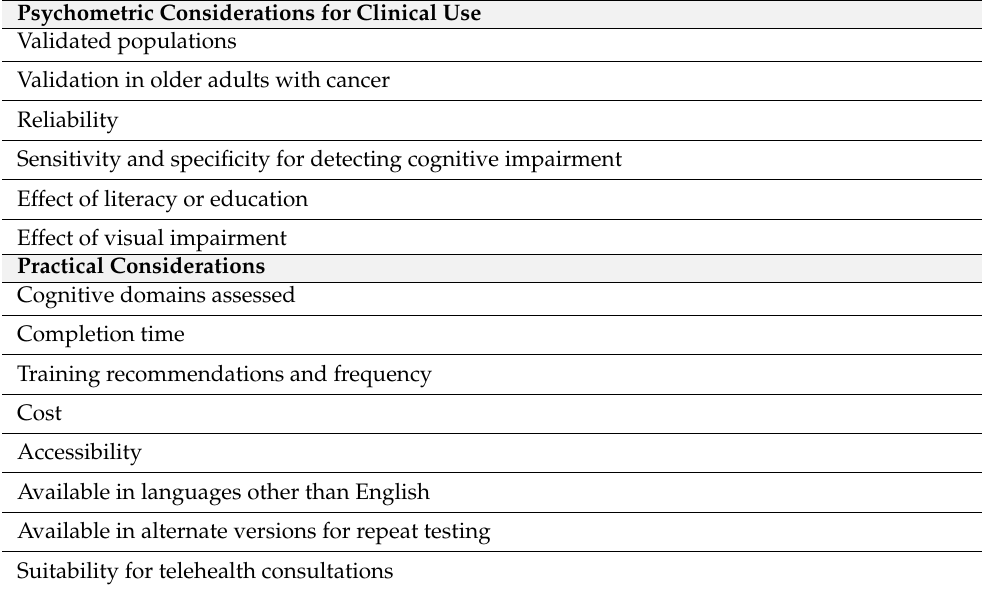
Table 2. Characteristics of cognitive assessment